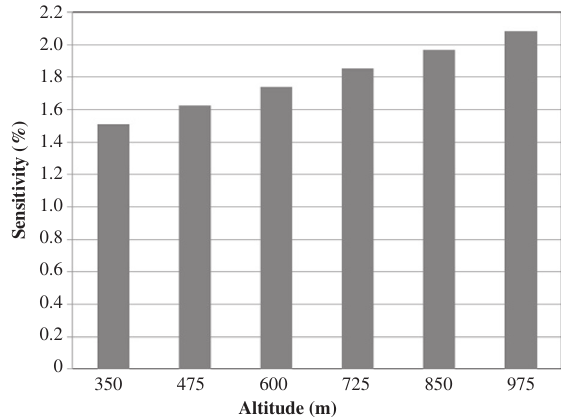
Fig. 11. Sensitivity of specific soot emission at the ECE-R49 standard test to the increase of 35 m of the altitude